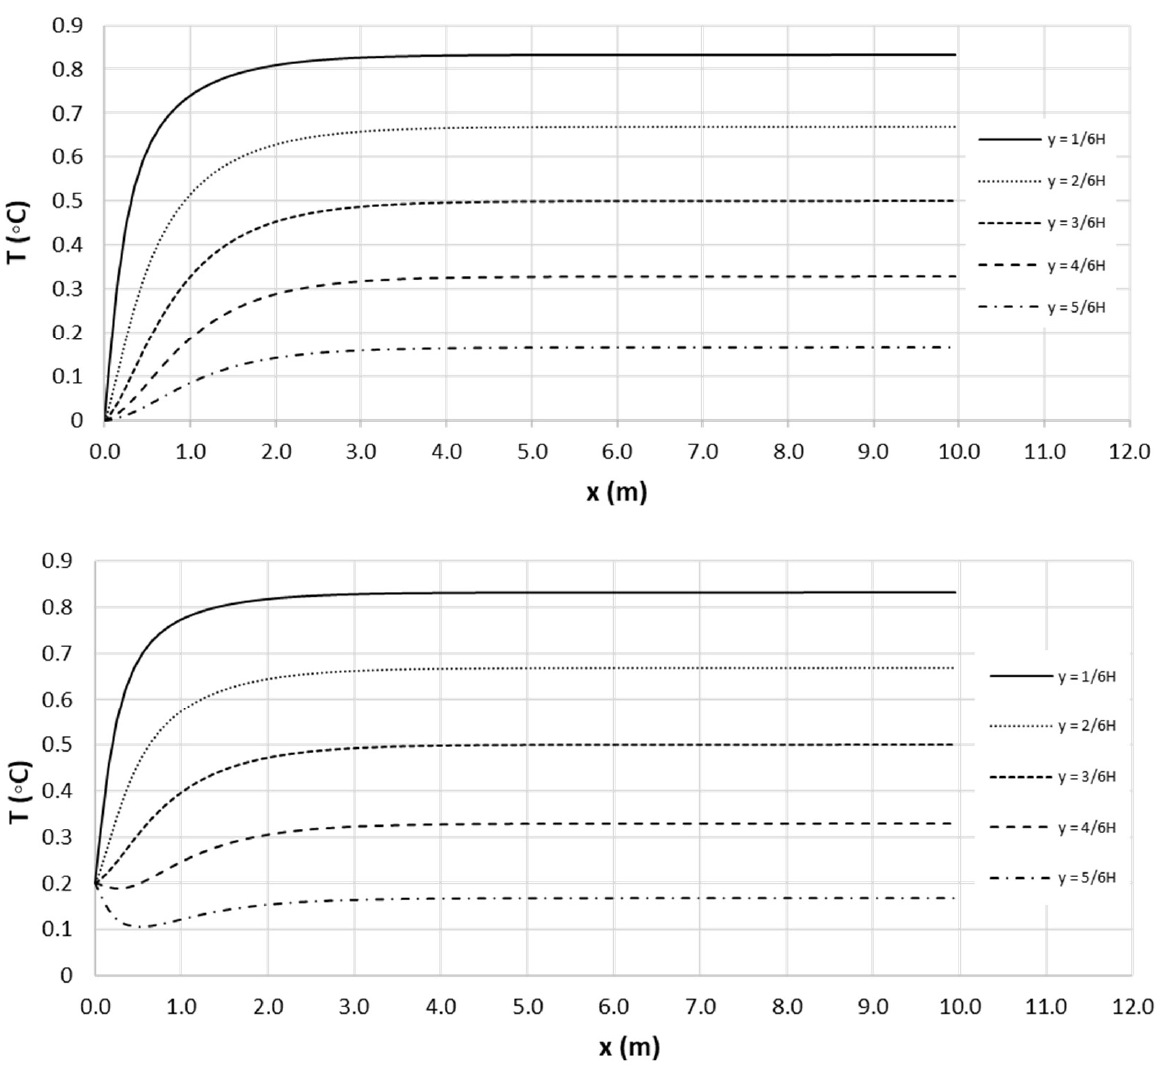
Figure 5. Steady-state, horizontal temperature profiles of Scenarios I ( up ) and III ( down ) at y = H , 2H , 3H , 4H and 5H 6 6 6 6 6 .